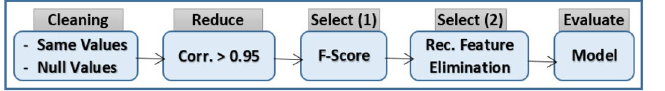
Figure 6. Feature processing and reduction